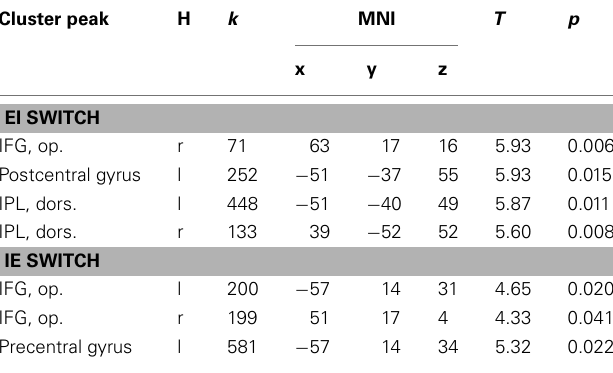
Table 1 | Overview of significant results of the ROI-analysis for the within-group comparisons of the two experimental groups ( α < 0.05, p -values are FWE-corrected , cluster size threshold k >